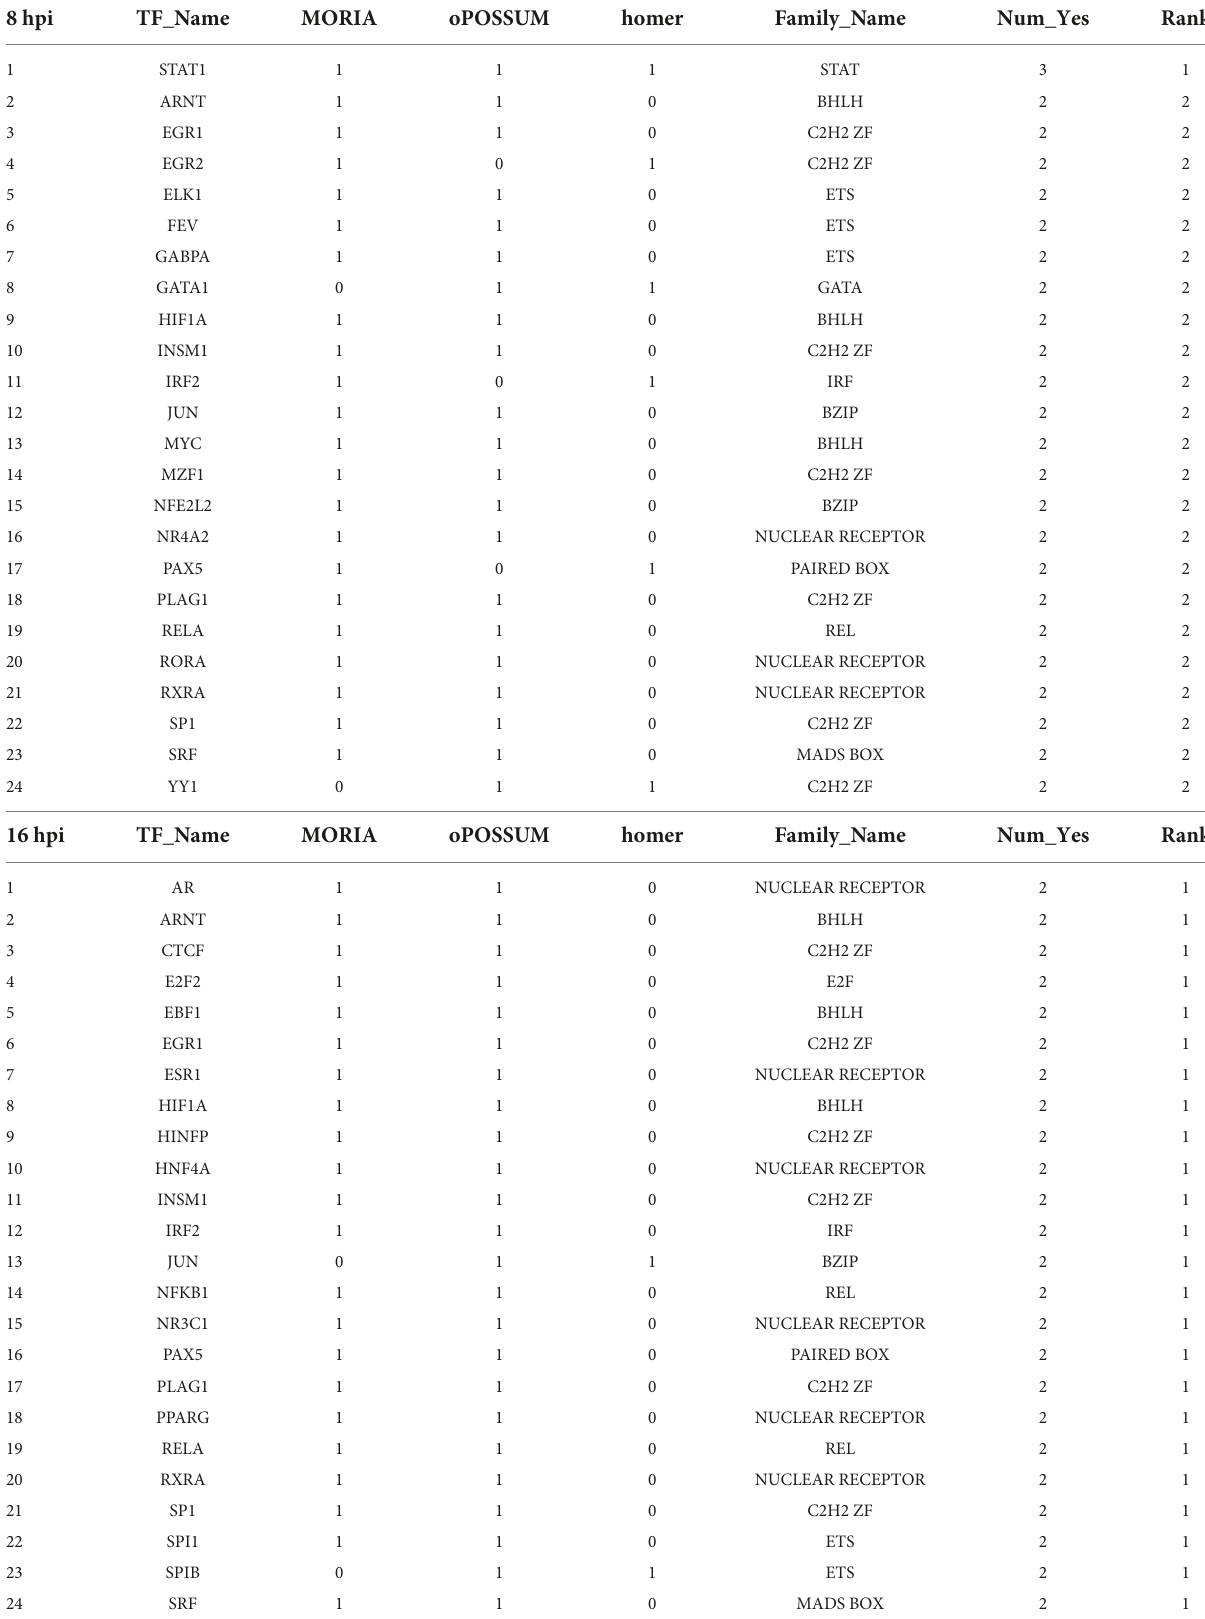
TABLE 2 TFs prediction binding sites of differentially up-regulated genes at 8, 16, and 24